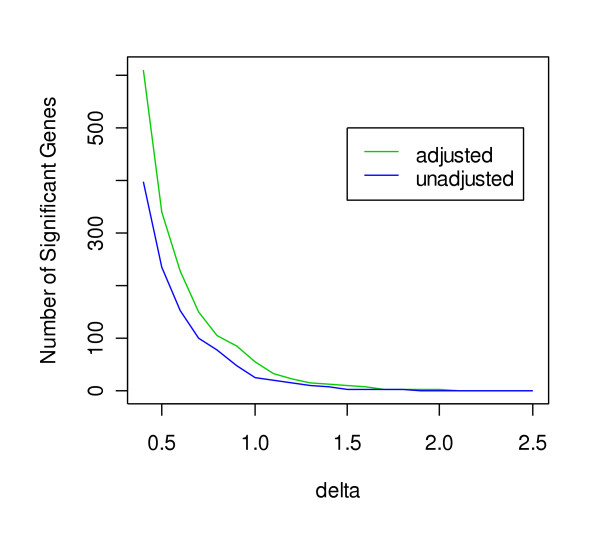
Relationship between number of significantly expressed genes and different delta levels, obtained from fitting the random effects model.